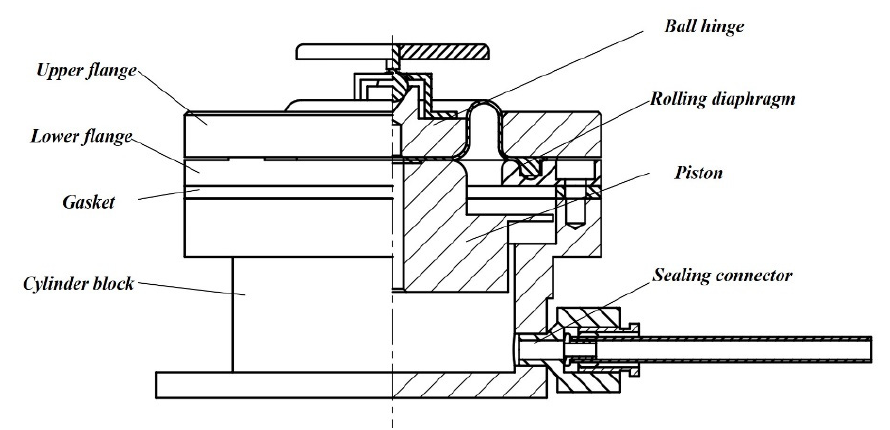
Figure 3. Half ‐ sectional diagram of the proposed single ‐ cylinder HSU.